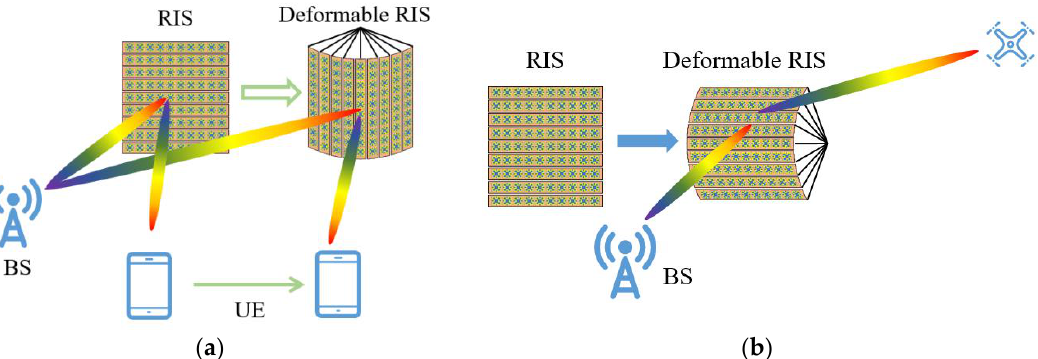
Figure 6. ( a ) Deformable RIS supporting the movement of ground UEs. ( b ) Deformable RIS supporting the communication of air UEs (e.g., drones).